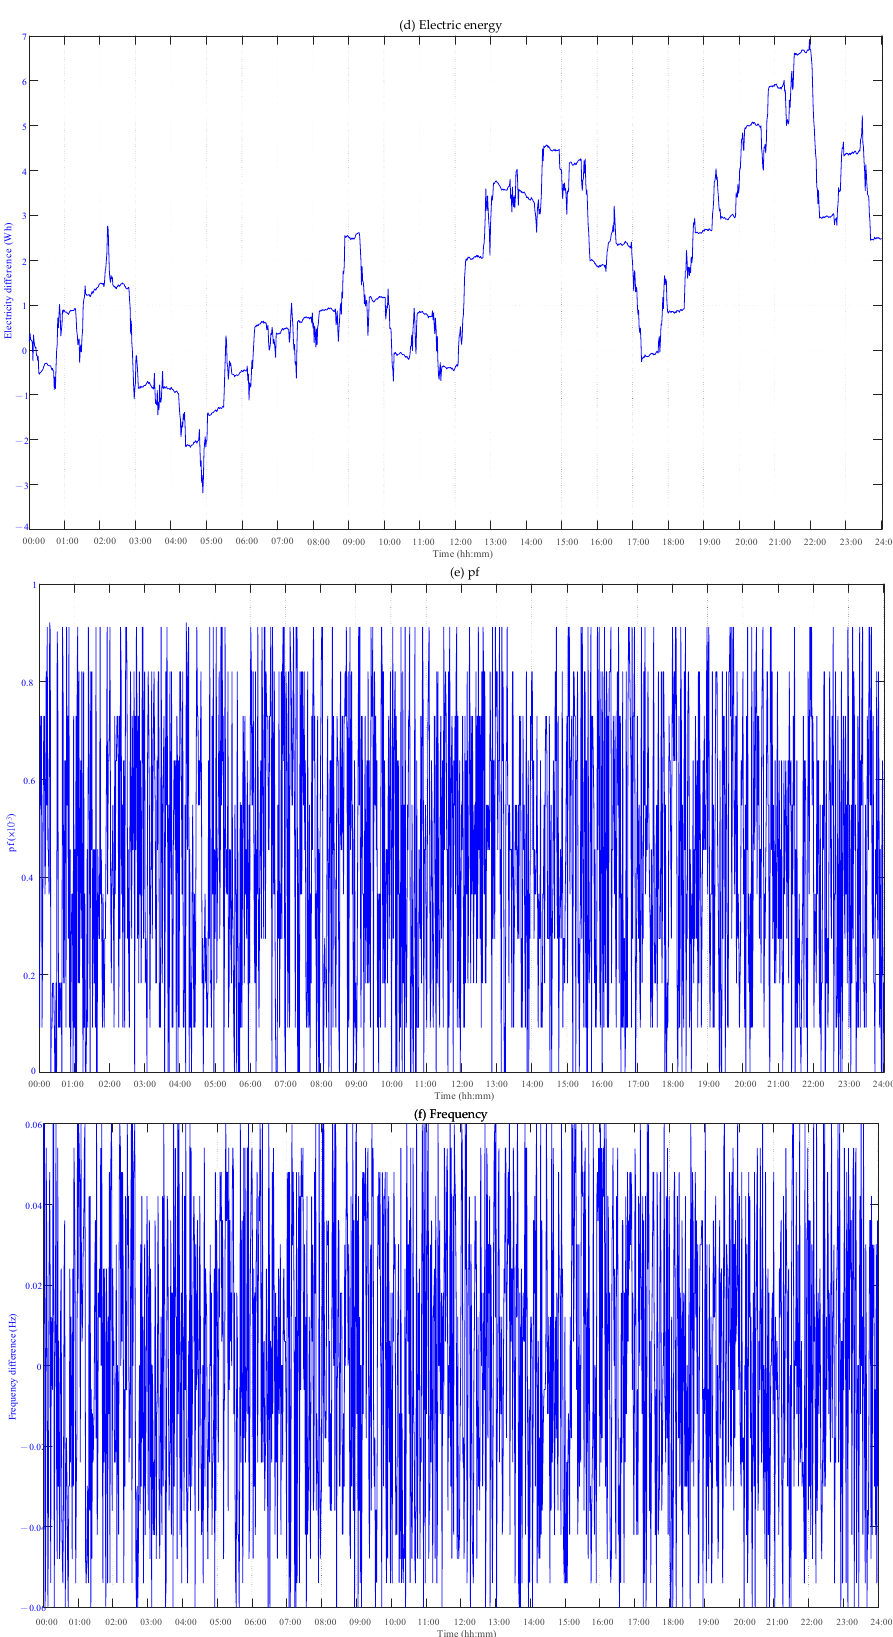
Figure 8. Close agreement analysis for 24 h measurement results of air conditioner: ( a ) Voltage; ( b ) Current; ( c ) Electric power; ( d ) Electric energy; ( e ) Power factor (pf); ( f ) Frequency (Hz).